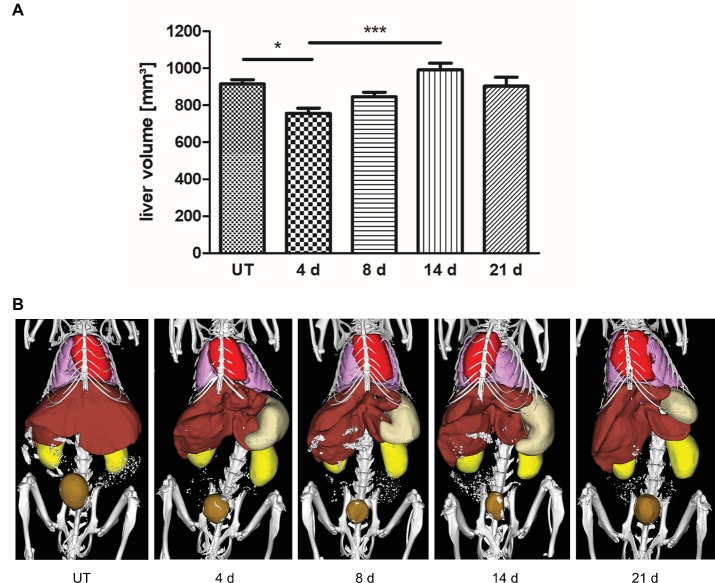
Liver volume recovery after PHx. Liver volume was determined non-invasively at day 4, 8, 14, and 21 after PHx and in untreated control mice by contrast-enhanced μCT. (A) Quantitative analysis showed that >70% and > 80% of the total liver volume were regained at day 4 and day 8 after PHx, respectively (*p < 0.05, ***p < 0.001; data are presented as mean values ± SD). (B) Representative 3D rendered CT images with segmented organs of an untreated control mouse and mice after PHx show the growth of the remaining liver lobes during regeneration (red, heart; pink, lungs; brown, liver; beige, stomach; ochre, bladder). UT, untreated mice.